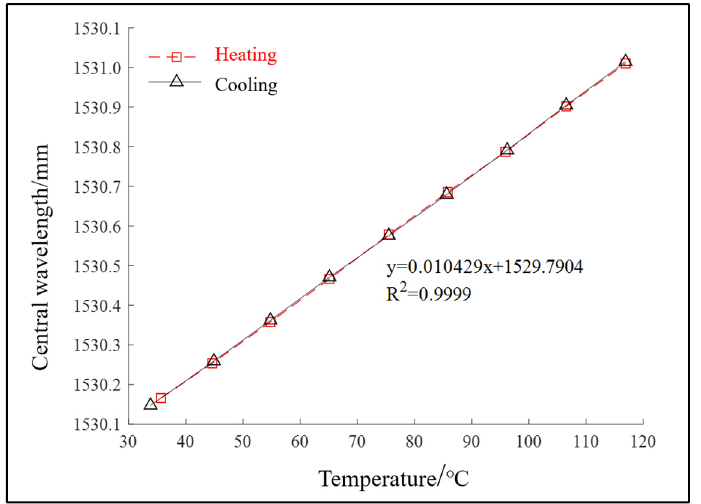
Figure 2. Wavelength–temperature curve.